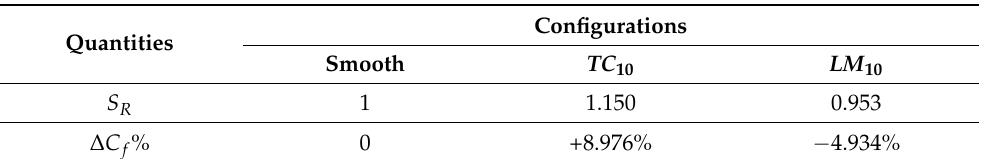
Table 5. Values of the total shear stress ratio between the lower and the upper walls ( S R = and the percentage change in the skin-friction drag coefficient ( ∆ C f %), with the porous substrates characterized by (cid:101) =